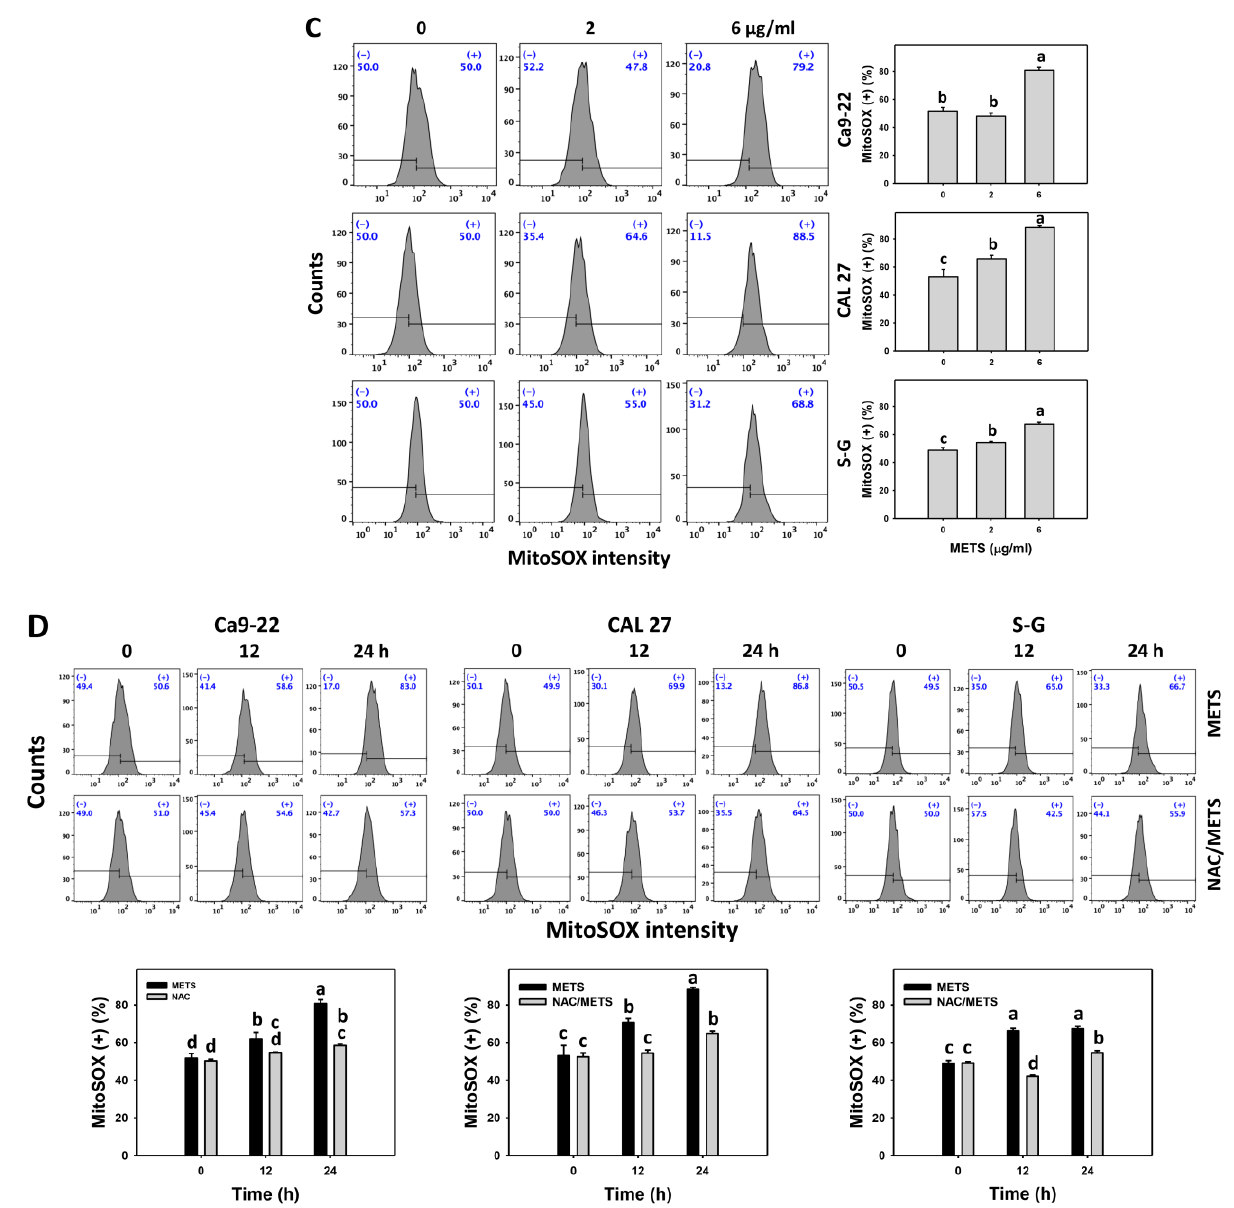
Figure 7. METS improves ROS and MitoSOX levels of oral cancer cells. ( A , C ) ROS and MitoSOX histogram changes. Cells were treated with METS for 24 h. Oral cancer and normal cells (S-G) were included. (+) indicates the high intensity of ROS and MitoSOX. ( B , D ) NAC response on ROS and MitoSOX levels. Untreated control and NAC pretreatment were followed by posttreatment of vehicle control and METS (6 μg /mL) for 0, 12, and 24 h, i.e., control, NAC, METS, and NAC/METS, respectively. Data = mean ± SD ( n = 3). Data showing non-overlapping lower-case letters provide significant results ( p < 0.05) as analyzed by the one-way ANOVA analysis and post hoc test.